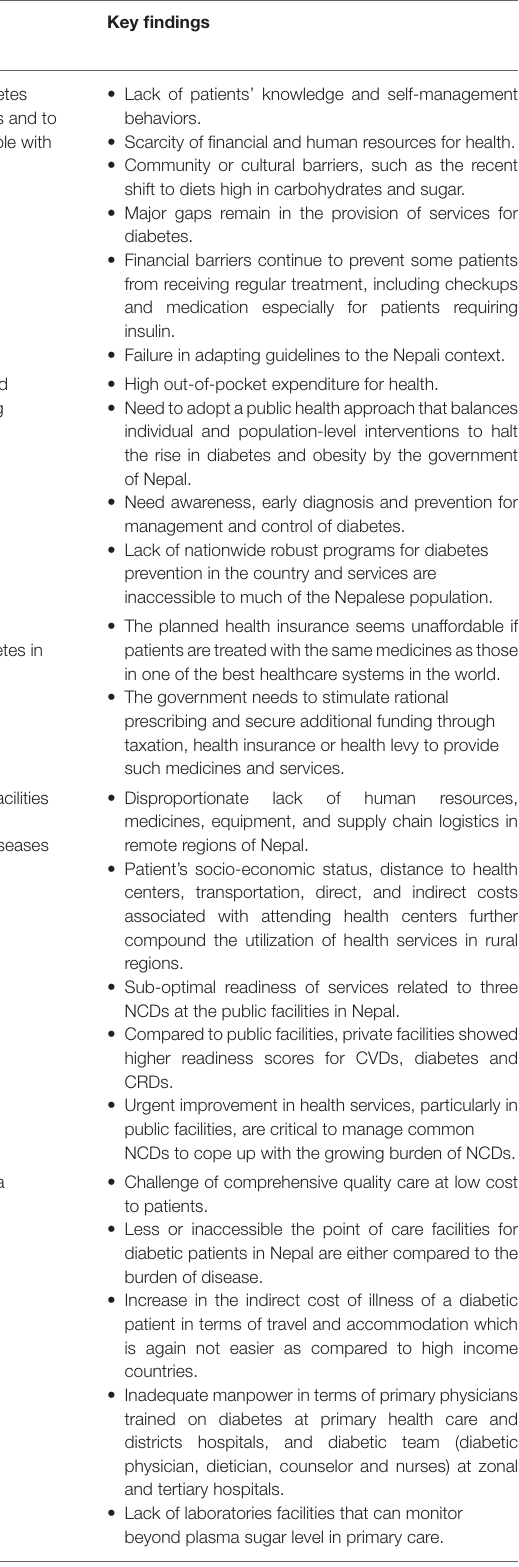
TABLE 3 | Publications related to prevention and control of diabetes in